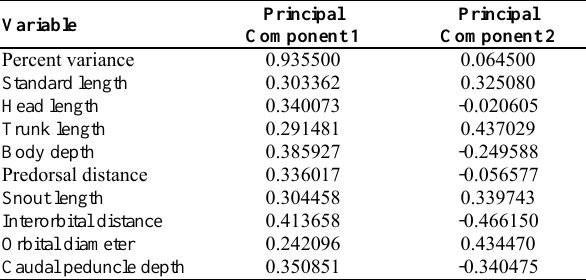
Table 2. Principal component analysis of Leporinus jamesi (n=13) and L. amazonicus (n=12). Variable loadings for principal components 1 and